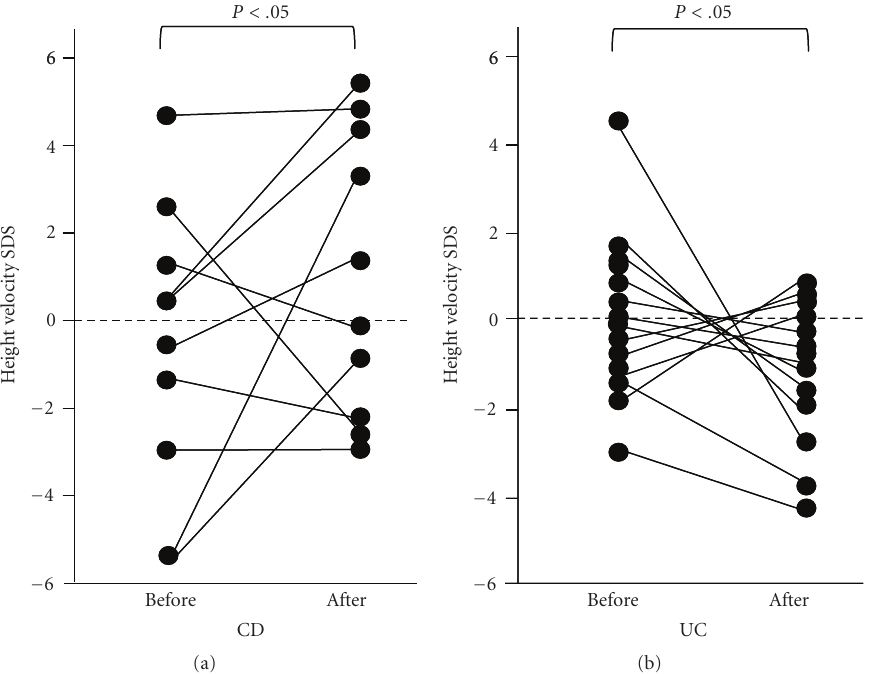
Figure 1: Comparison of growth rate SDS between children with CD and those with UC during the 1-year period before the initial assessment and the 1-year period subsequent to the initial assessment. before: 1 year to initial visit; after: from initial visit to 1 year